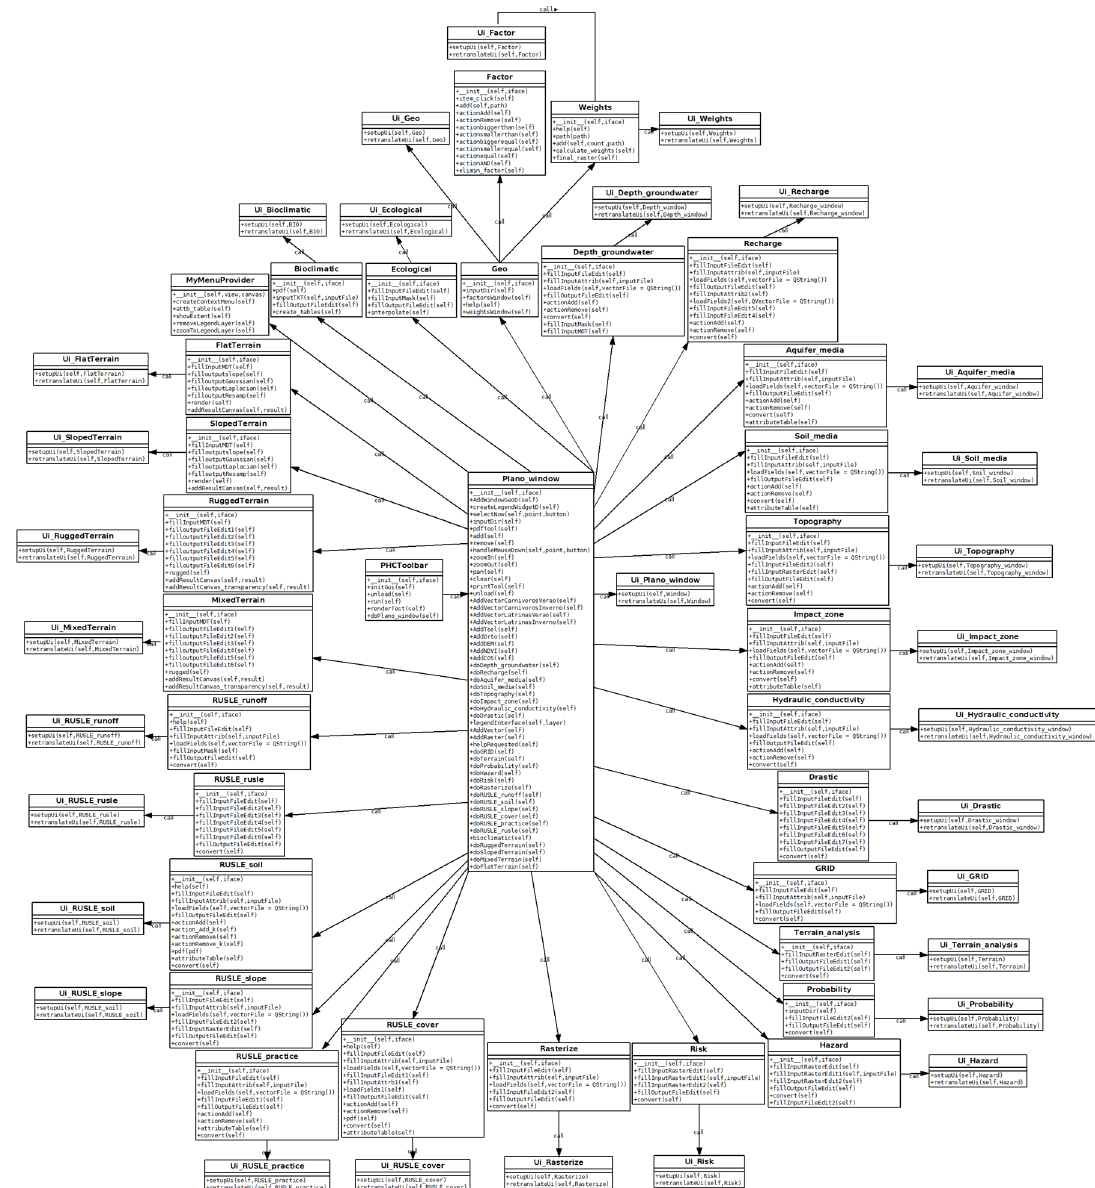
Figure 2. Herdade da Contenda Integrated Environmental Management System (HCIEMS) class diagram.